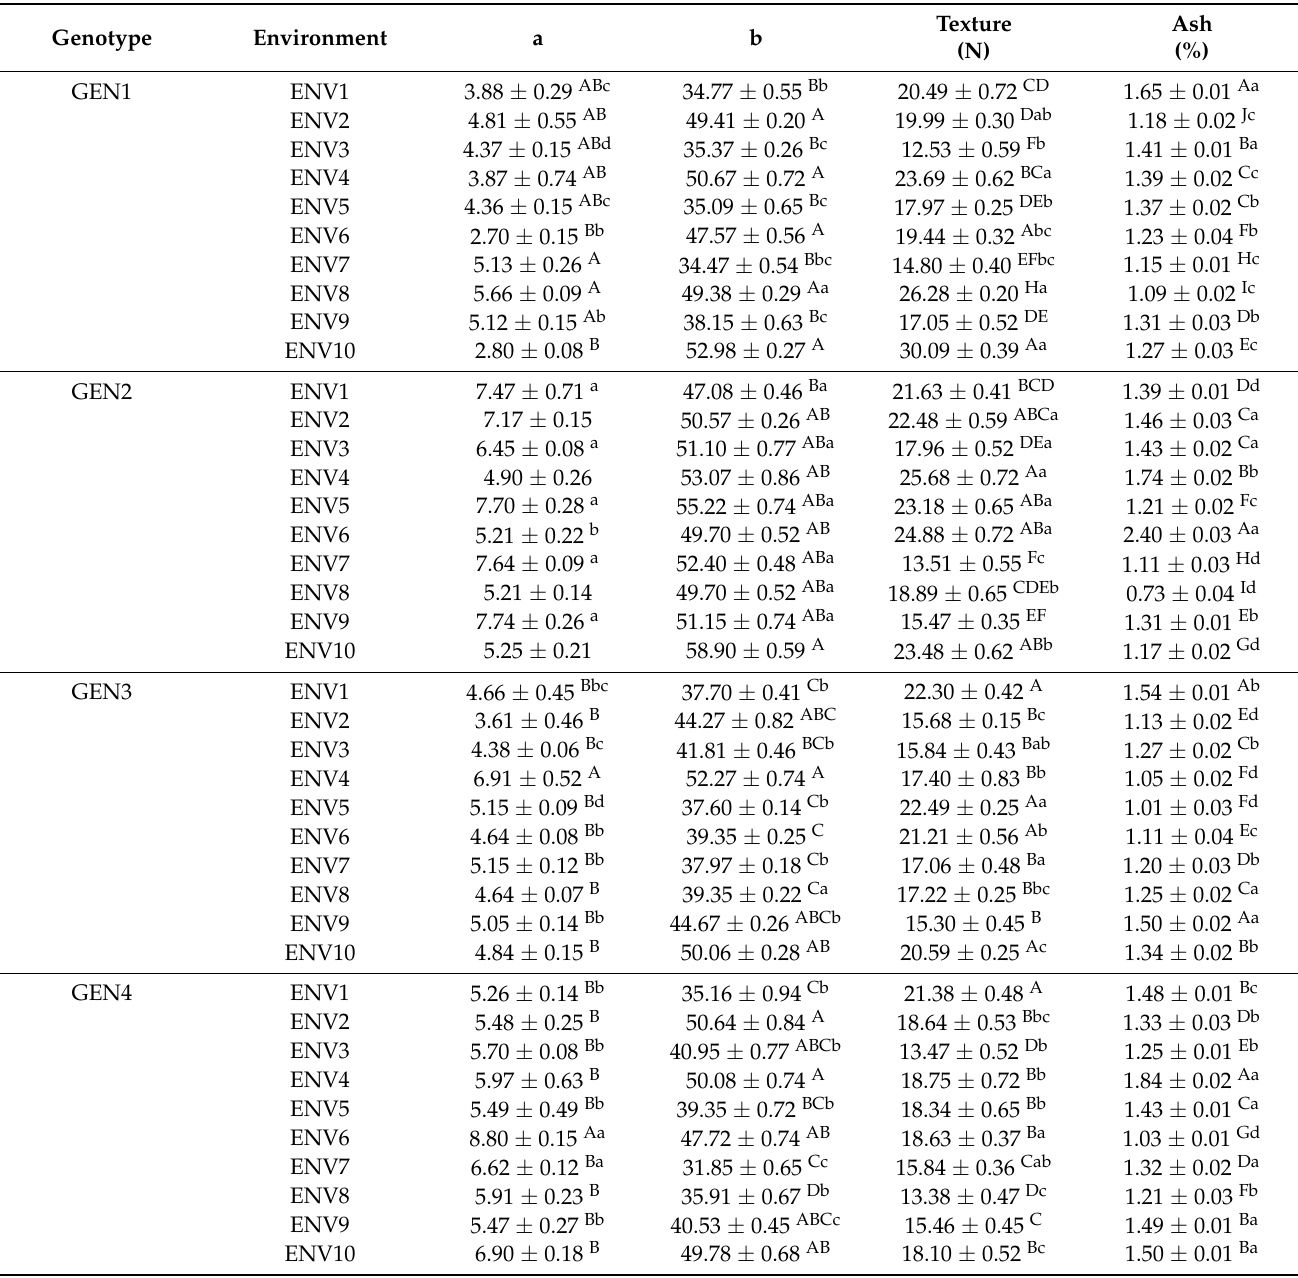
Table 1. The performance (color parameters) for corn grains varied across different environ- ments. The lightness (L) across all cultivars ranged from 34.28 to 78.23, the yellow index b ranged from 34.47 to 58.90 and the red index a ranged from 3.61 to 8.80. For L, a and b color parameters, there was a significant difference between genotype ( p < 0.001), environments ( p < 0.001) and for their GE interaction, except for the interaction on the red index. The highest values of L color parameter of corn grains were obtained from the